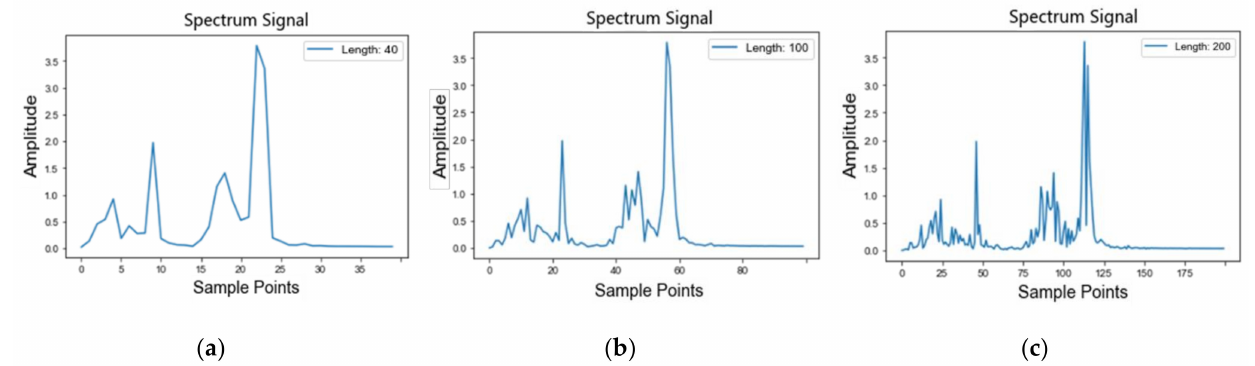
Figure 8. The spectrum of the multi-scale original signals: ( a ) low-scale; ( b ) mesoscale; ( c ) high-scale. The frequency-domain signal maps of the generated balanced dataset E’ at 40, 100, and 200 scales are shown in Figure 9a–c, respectively. In the same way, the imbalanced datasets A and F are used to obtain the corresponding multi-scale balanced generated sample datasets C and F’, respectively. Eventually, these multi-scale balanced datasets will realize fault diagnosis through the MACNN-BiLSTM model of the multi-scale attention mechanism. The experimental results illustrate that MS-PGAN can generate realistic multi- scale frequency spectral signals and accord with the physical mechanism of signals, which can effectively alleviate the problem of data imbalance.